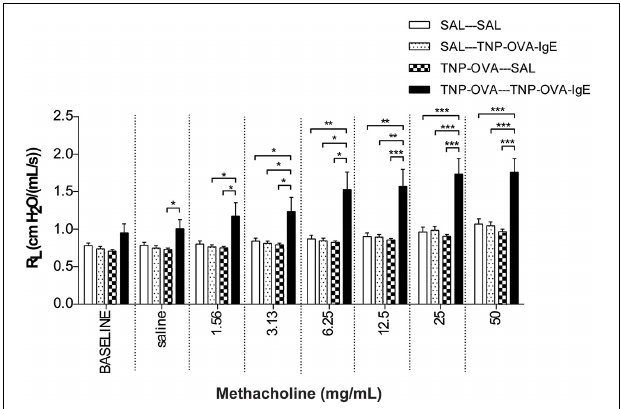
FIGURE 5 | Resistance measurement (R L )to methacholine in the severe airway inflammation model. Resistance was measured in ventilated mice sensitized with saline or TNP-OVA and challenged intranasally with saline or TNP-OVA-IgE. Values are expressed as mean ± s.e.m. ∗ P < 0 . 05, ∗∗ P < 0 . 01, ∗∗∗ P < 0 . 001; using a One-Way ANOVA followed by a Bonferroni post-hoc analysis, n = 9 mice/group.